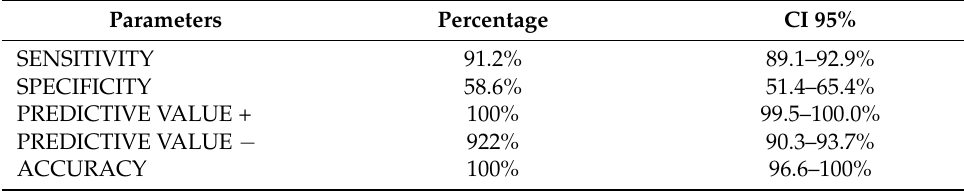
Table 8. Predictive values in occlusal faces.